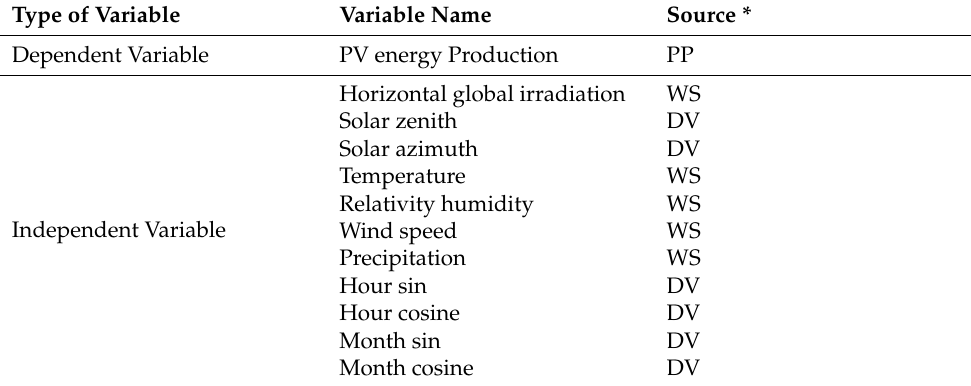
Table 2. Dependent and independent variables initially considered.